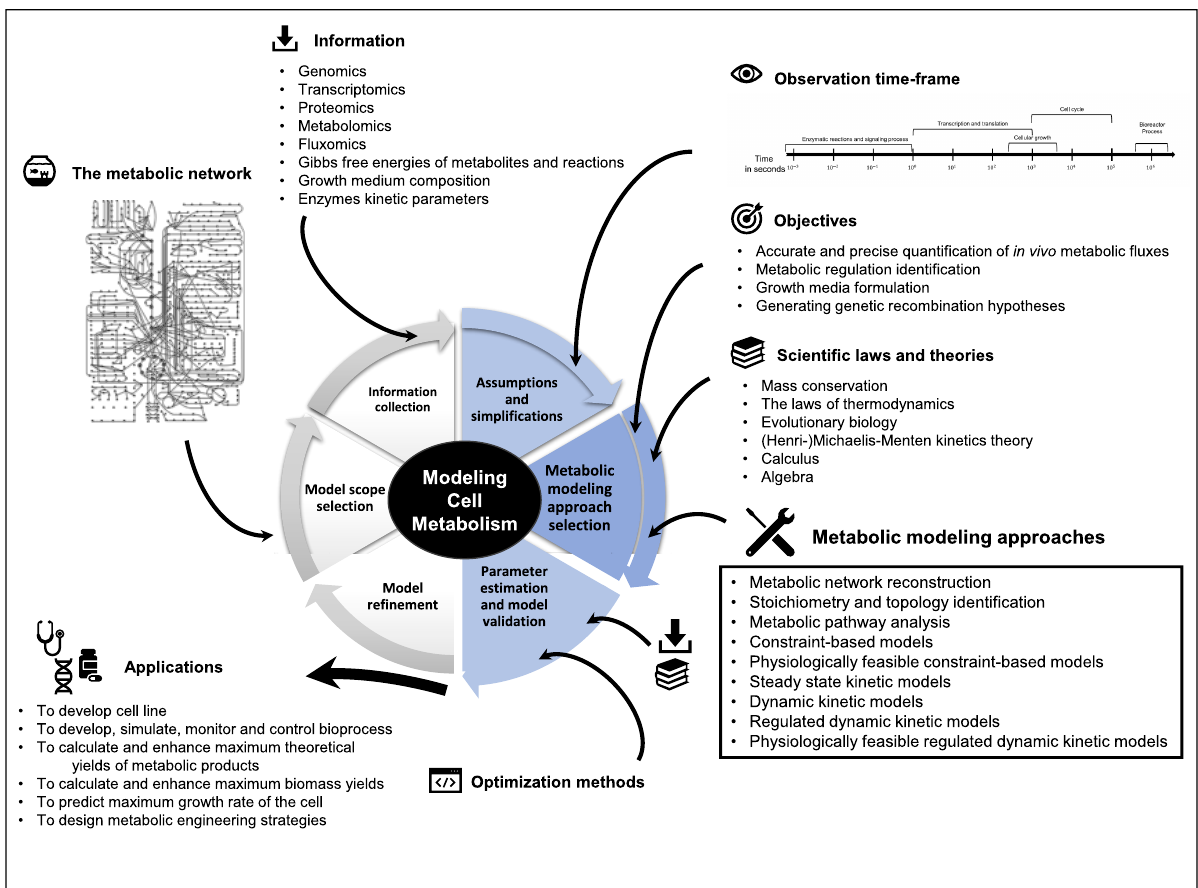
Figure 8. A general workflow of kinetic parameter estimation.